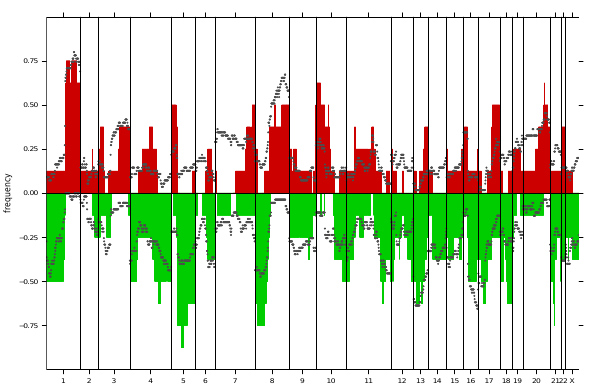
Figure 5: Gains (upper red) and losses (lower green) frequencies of the eight misclassified samples are compared to the frequencies for the remaining 55 samples (gray dots).